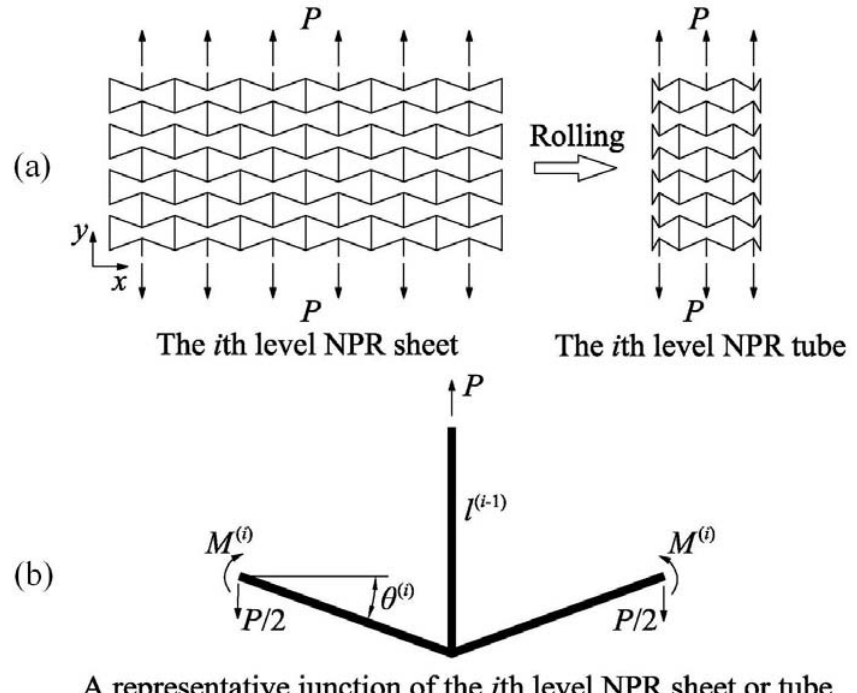
Figure 2. ( a ) Schematics of the i th ( 1 i N   ) level NPR sheet and the corresponding i th ( 1 i N   ) level NPR tube made by rolling the NPR sheet; ( b ) the force diagram of a representative junction of the i th ( 1 i N   ) level NPR sheet or tube subject to the y -axis